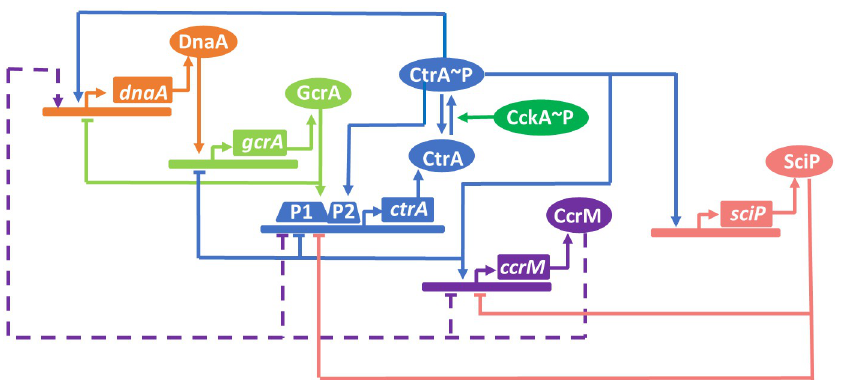
Fig 3. The master regulatory network of C. crescentus . Solid lines represent activation/inhibition influences of master regulators (DnaA, GcrA, CcrM, CtrA, SciP) with arrow/bar, respectively. The dashed lines represent the methylation effects on dnaA , ctrA , ccrM genes from